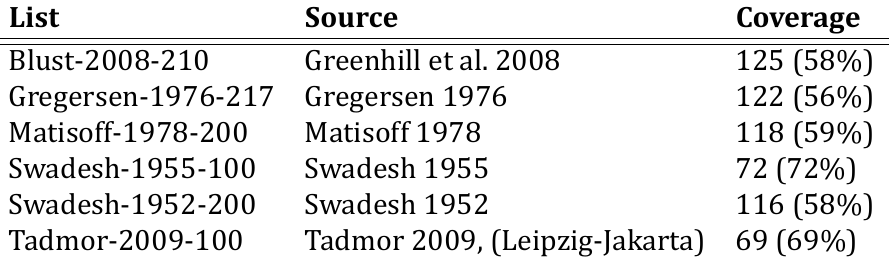
Table 3: Overlap with popular basic vocabulary